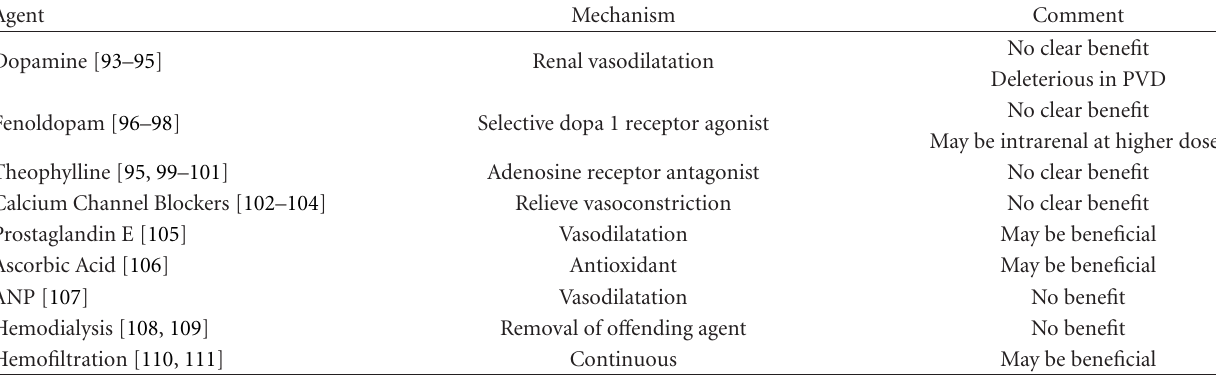
Table 5: List of agents assessed for prevention of CIN and the literature available on each.